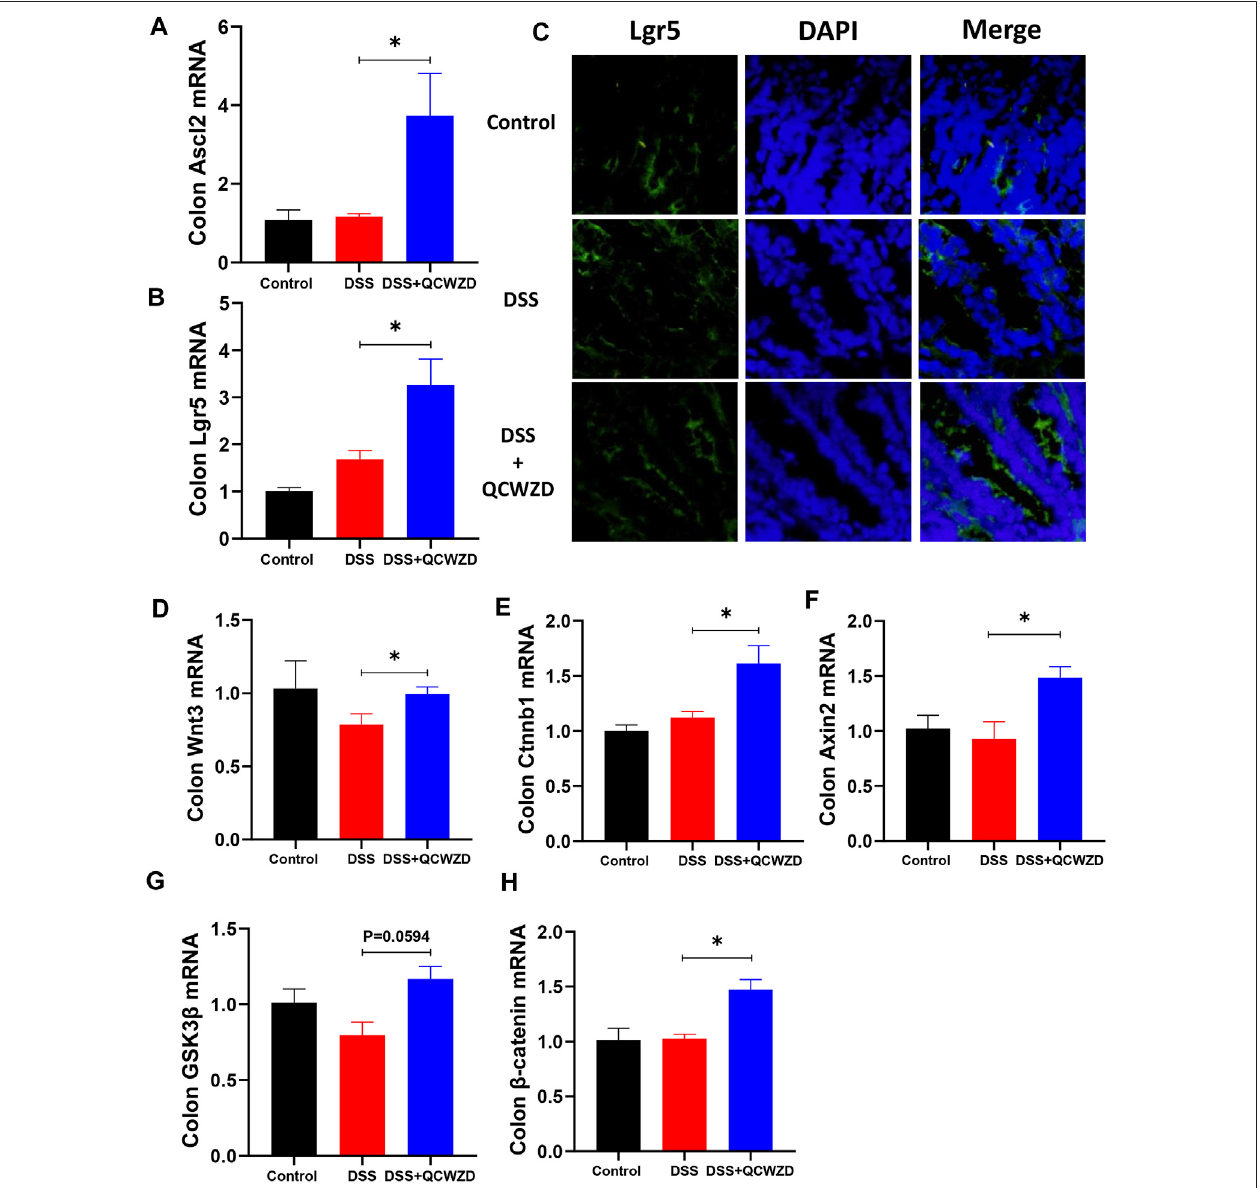
FIGURE7| IntestinalStemCells-MediatedEpithelialRegenerationPromotedbyQCWZDAdministrationIsIndispensableforMucosalHealingAfterDamage.Colon tissues were collected from control or DSS-treated mice after 1-week 1.8 g/kg QCWZD treatment or sterile water for further analysis. (A, B) The relative mRNA levels of intestinal stem cells markers (Ascl2 and Lgr5) in colon were determined by RT-qPCR. (C) Confocal images (Lgr5 staining, red; and DAPI staining, blue) of the colon with different treatments. (D – H) RT-qPCR of relative mRNA expression of Wnt3, Ctnnb1, Axin2, GSK3 β , and β -catenin genes of the Wnt/ β -catenin axis in colon from each mouse. Thedata shown are the mean ± the SEM( n (cid:2) 4 – 6mice/group)from one ofthree experiments performed showing similar results. p p < 0.05versusthe DSS group. Signi fi cance was determined by one-way ANOVA test (Tukey ’ s multiple comparison test).